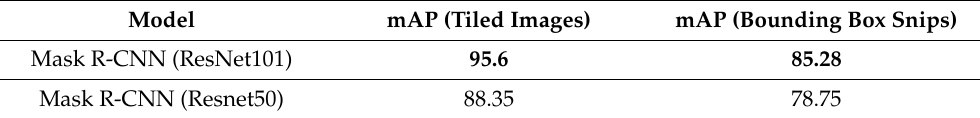
Table 5. Mean average precisions (mAP) of trained Mask R-CNN models.